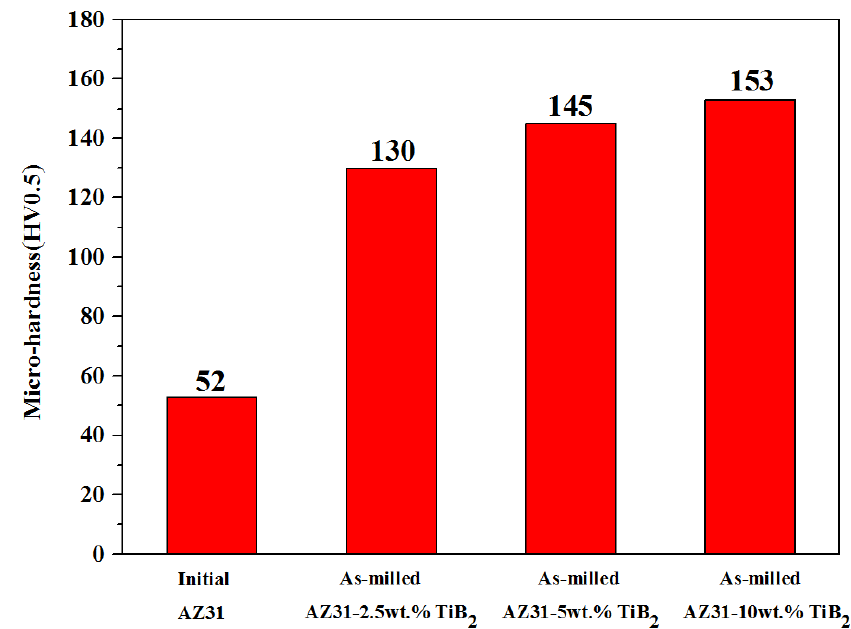
Figure 10. The Vickers micro-hardness of the as-cast AZ31 Mg alloy and as-milled AZ31 / TiB 2 composites after milling for 110 h.